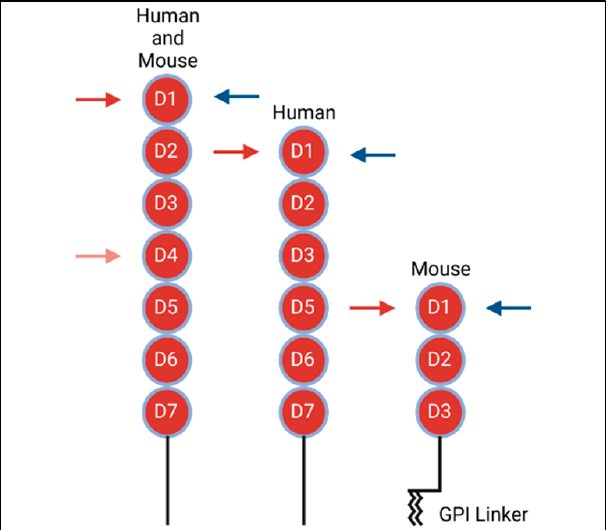
Figure 1. Structures of human and mouse VCAM-1 isoforms. Red circles represent Ig-domains. Red arrows denote VLA4 ( α 4 β 1) binding sites on VCAM-1. Blue arrows denote α 4 β 7 binding sites on VCAM-1.